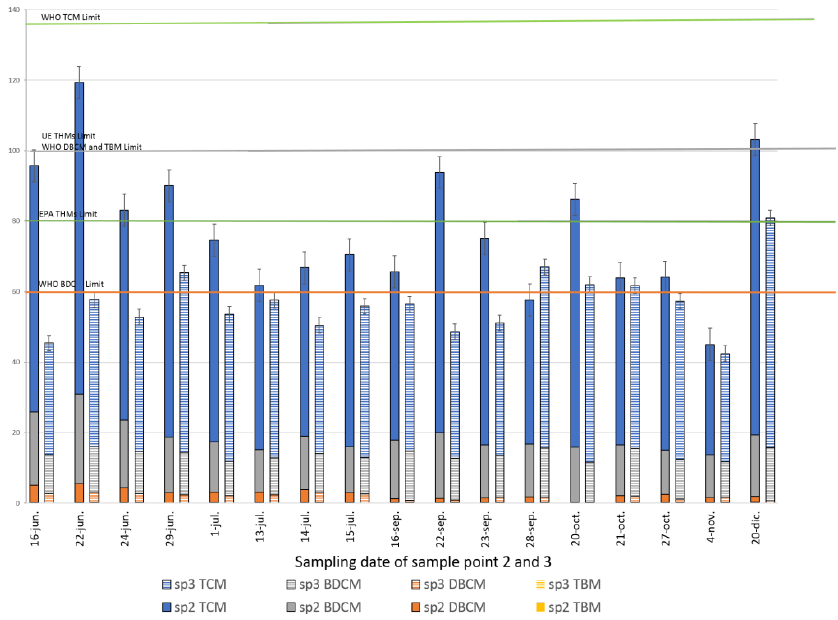
Figure 5. Total THMs concentration in the inlet (sample point 2) and in the exit of the chlorine sta- bilization chamber (sample point 3 of Figure 1) from June to December 2021.